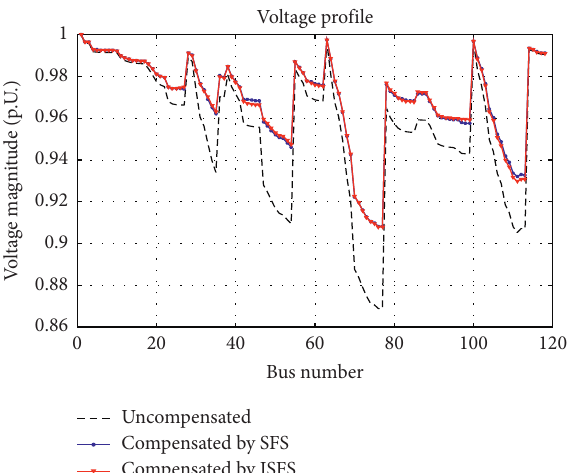
Figure 19: Bus voltage profile of 119-bus network with 100% loading in scenario